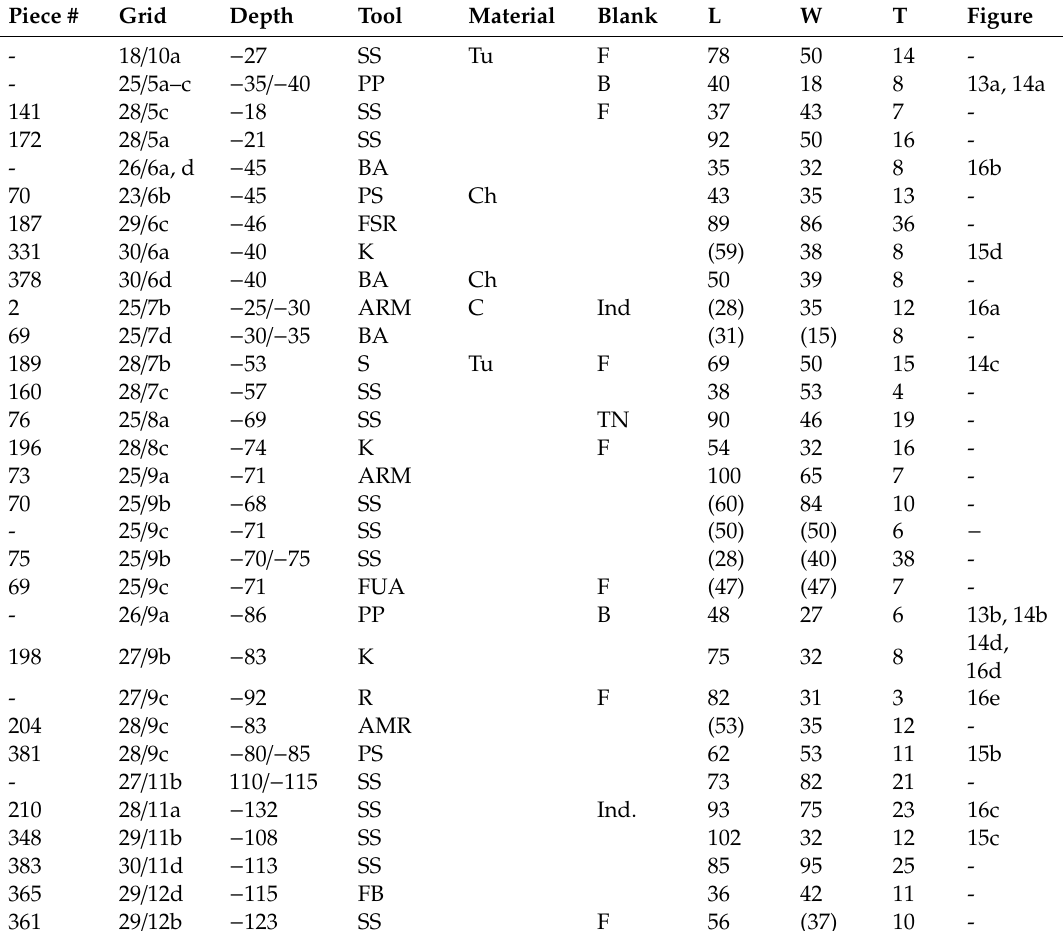
Table 2. The salient morphological and technological attributes of the CM lithic artifacts reported in this paper. References: AMR: Artifact with marginal retouch, ARM: Artifact with marginal retouch in a restricted angle, B: Biface, BA: Bifacially flaked artifact, C: Chert, Ch: Chalcedony, EA: Edge angle, FB: Fractured biface, FUA: Fragment of unifacial artifact, FSR: Flake with summary retouch, L: Length, PP: Projectile point, PS: Perimeter scraper, R: Raclette, S: Scraper, SS: Side scraper, Tu: Tu ff , T: Thickness, W: Width. Note: All the measurements are given in mm, (): indicates a fractured